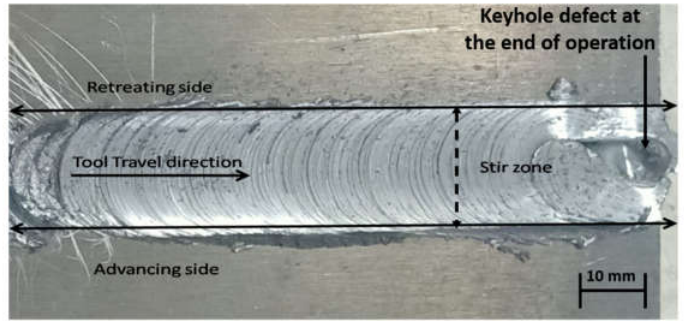
Figure 4. Photographic view of Al359/Si 3 N 4 /Eggshell surface composite after FSP.